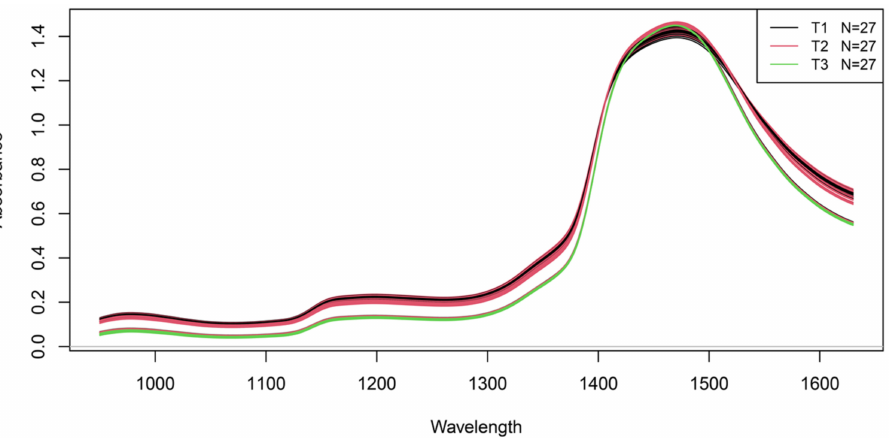
Figure 2. NIR spectra of probiotic samples according to temperature level T1 (25 ◦ C), T2 (60 ◦ C), and T3 (90 ◦